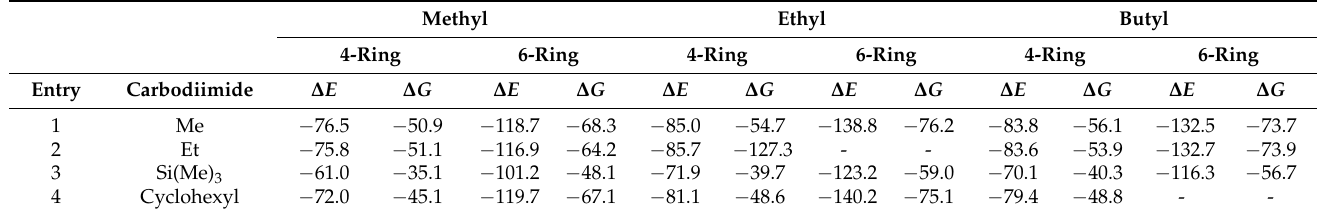
Table 4. Interaction energies and free energies ∆ E and ∆ G for the alkyl magnesium-additive com- plexes depicted in Figure 5. The values for the formation of 4-numbered ring structures and the intercalation to the chain to form 6-ring structures are